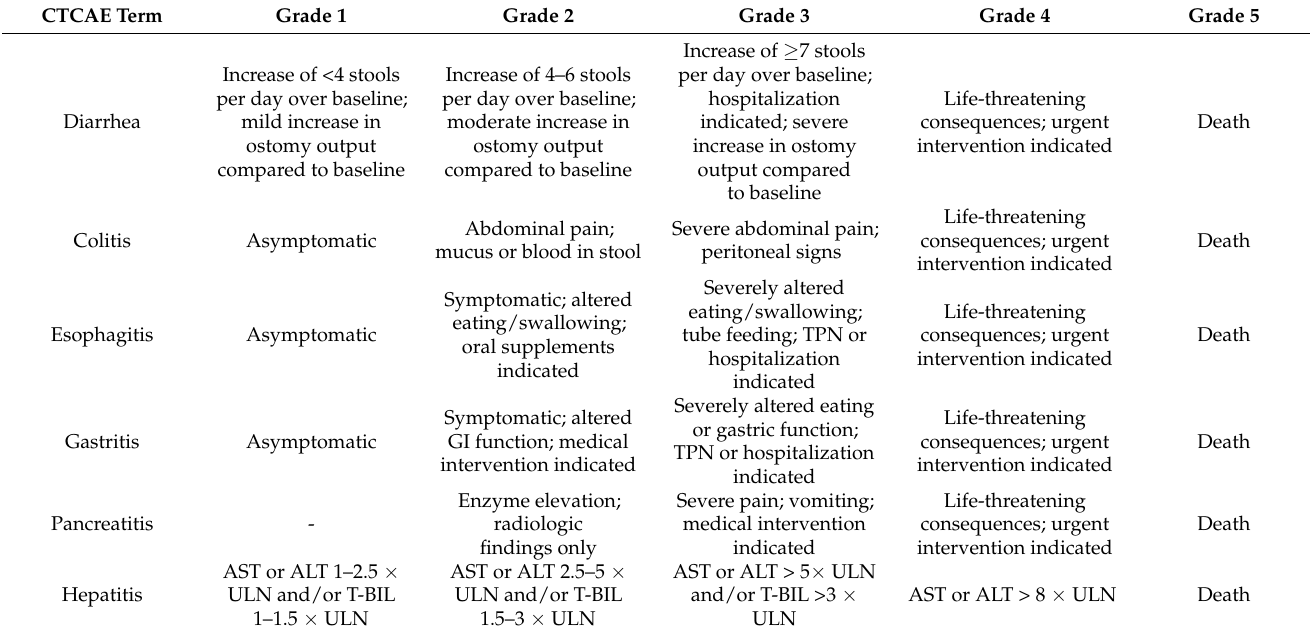
Table 1. Common terminology criteria for adverse events (CTCAE). Definitions of irAEs of the gastrointestinal